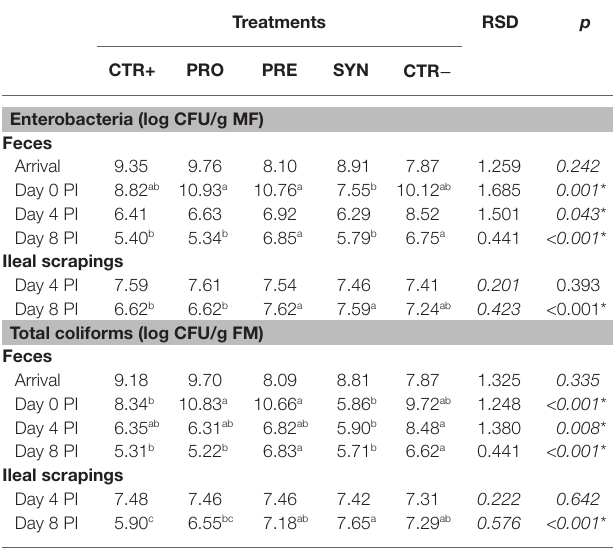
TABLE 4 | Effects of experimental treatments on enterobacteria and coliform counts in fecal samples and ileal scrapings.